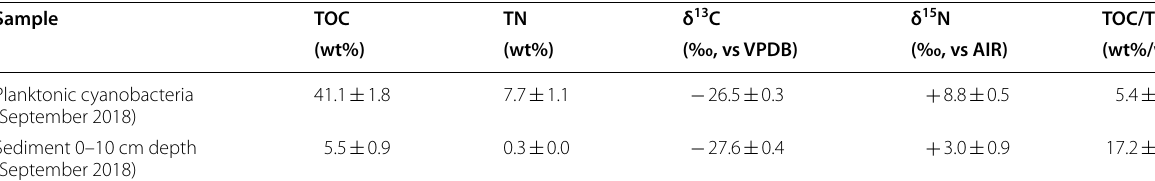
Table 1 Carbon and nitrogen contents and their stable isotopic compositions in the planktonic and benthic samples Sample